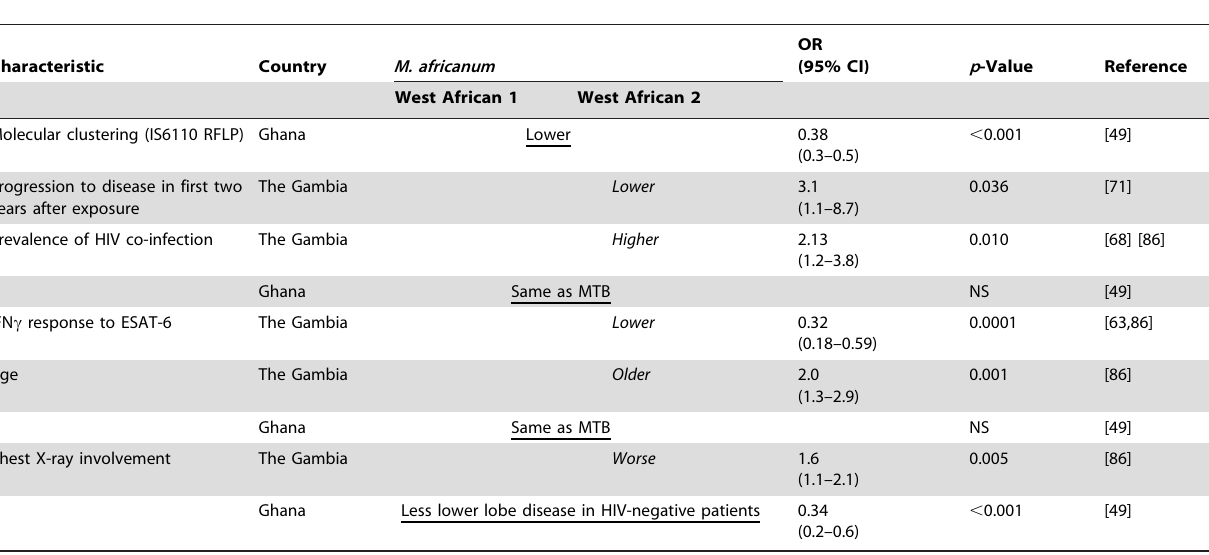
Table 3. Epidemiological, Clinical, and Immunological Differences of M. africanum Relative to M. tuberculosis .